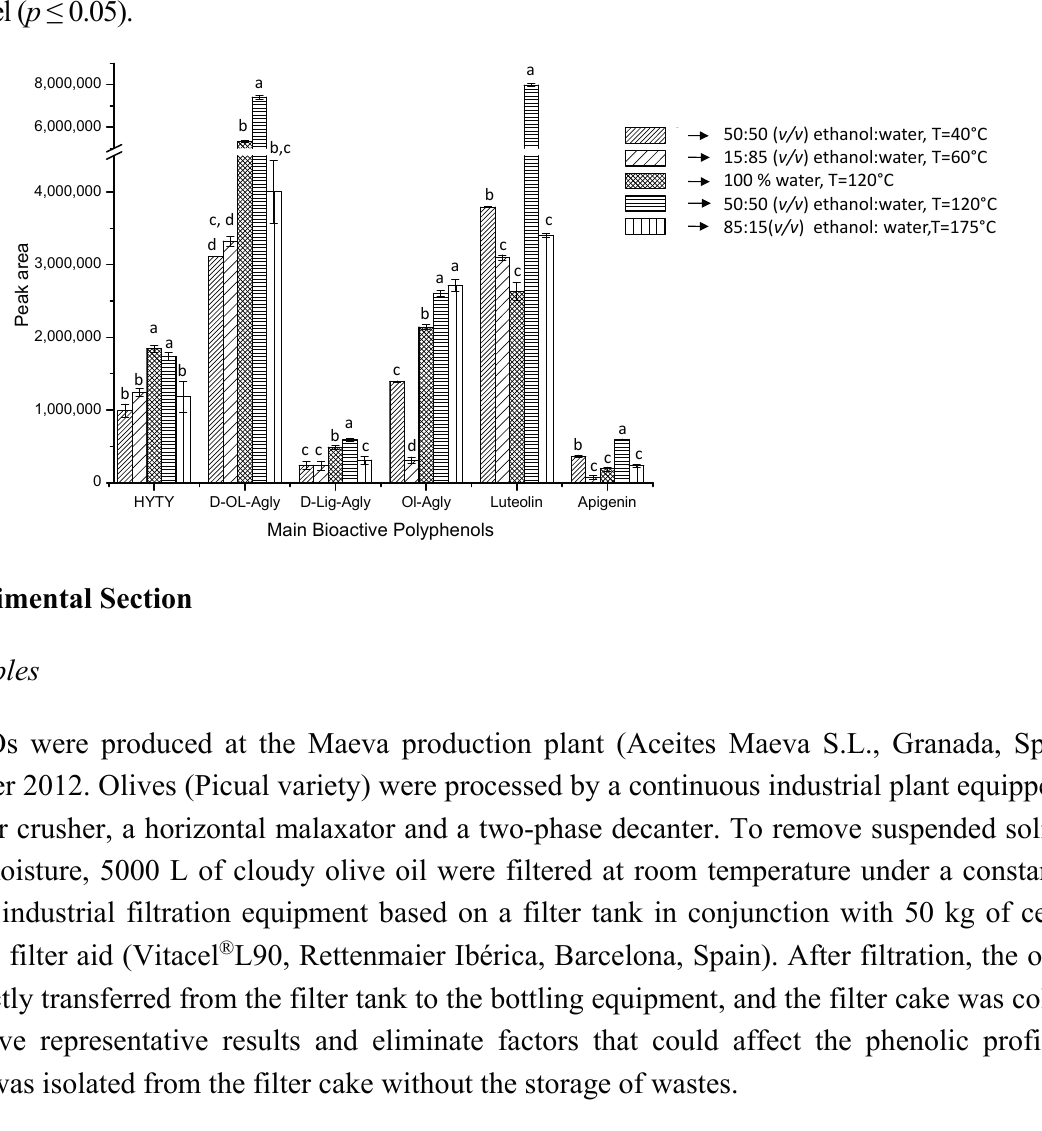
Figure 3. Peak area of the main bioactive phenolic compounds characterized in filter cake (HYTY, hydroxytyrosol; D-OL-Agly, decarboxymethyl-oleuropein aglycone; D-Lig-Agly, decarboxymethyl-ligstroside aglycone; Ol-Agly, oleuropein aglycone; luteolin and apigenin) under different PLE conditions. Values with the same letter (a, b, c or d) show that there is no statistically significant difference between the area of these compounds at the 95% confidence level ( p ≤